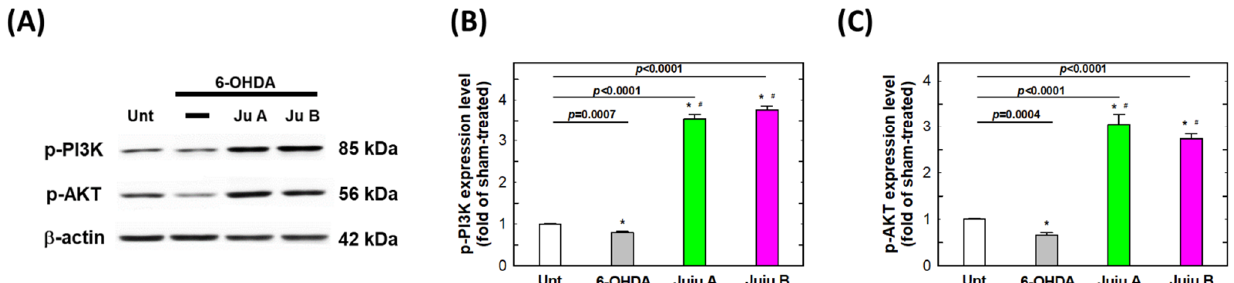
Figure 9. The signaling patterns altered by the treatments of 6-OHDA and jujubosides. ( A ) Western blotting was conducted specifically for p-PI3K and p-AKT. ( B ) Quantitative analysis of the intensities of p-PI3K bands. ( C ) Quantitative analysis of the intensities of p-AKT bands. β-actin served as an internal loading control in each repeat of experiment. * significant different from untreated group. # significant different from the 6-OHDA treated group.